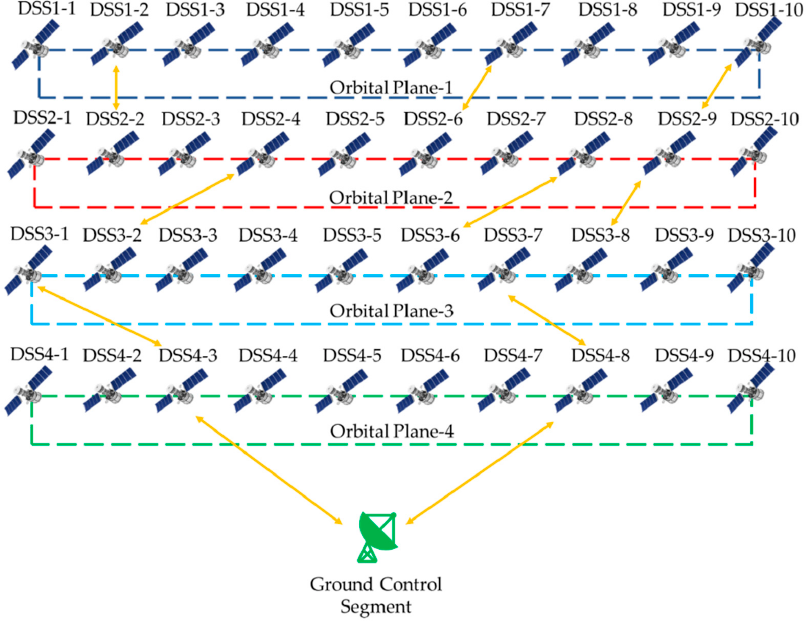
Figure 6. An instance of the proposed EO constellation illustration with inter-orbital plane ISL and ground link. Coverage Analysis: An imprint in the shape of a circle or rectangle is left on the sur- face of the Earth whenever a satellite is used to observe a particular area. The separation between the spacecraft and a targeted point within the satellite’s field of view region (also known as the imprint region) at a specific point in time is referred to as the instantaneous coverage of the satellite. The value of the Earth central angle λ is determined by the fol- lowing equation where (cid:4666)Θ (cid:2929) ,Λ (cid:2929) (cid:4667), denotes the latitudes and longitudes of the sub-satellite point and (cid:4666)Θ (cid:2930) ,Λ (cid:2930) (cid:4667) denotes the latitudes and longitudes of the target [51]. cosλ = sinΘ (cid:2929) sinΘ (cid:2930) (cid:3397) cosΘ (cid:2929) cosΘ (cid:2930) cos|Λ (cid:2929) − Λ (cid:2930) |